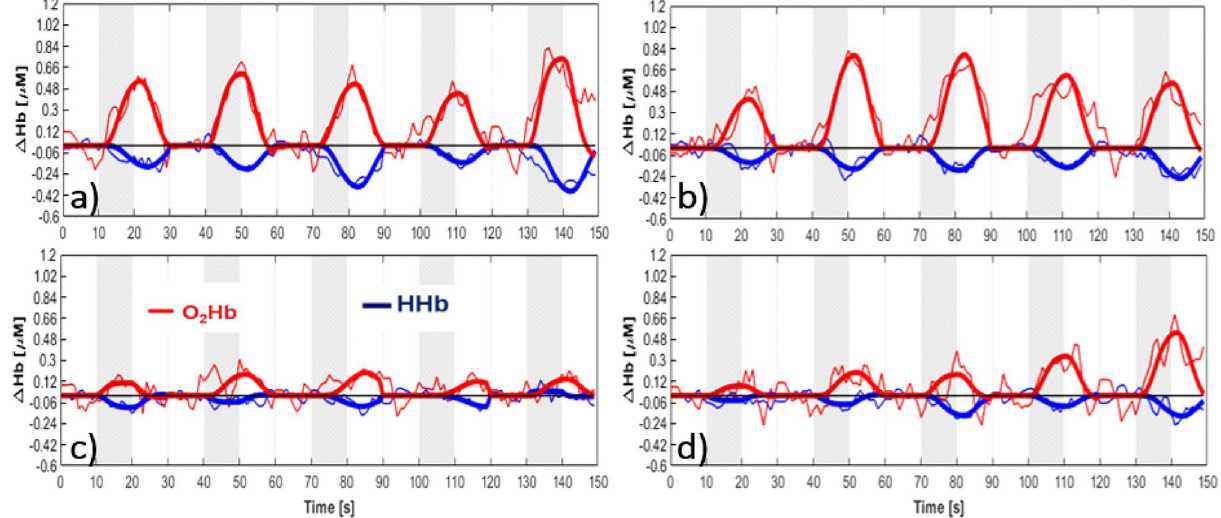
Figure 1. Typical TD-fNIRS time courses (thin line) for O 2 Hb (red) and HHb (blue) concentration changes and corresponding fitting with the HRF (thick lines) for a control subject ( a,b ) and a glaucoma patient ( c,d ) in the left ( a–c ) and right ( b–d ) hemisphere. The results are shown for the stimulation of the right eye. The stimuli periods are represented in grey.